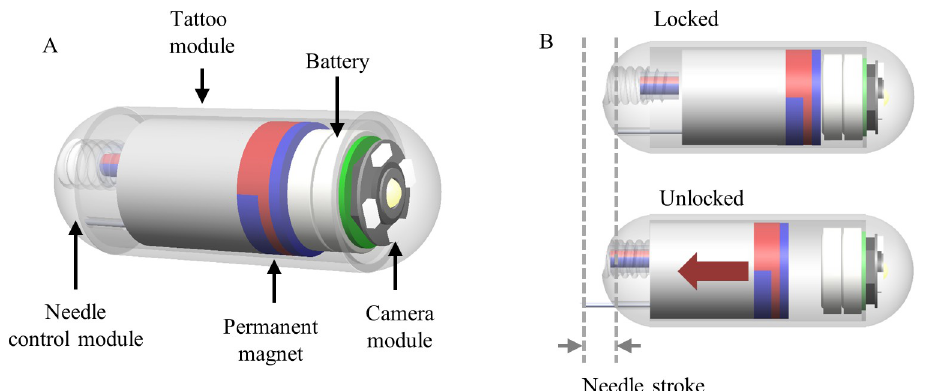
Fig 2. Schematics of the TCE. (A) Conceptual design of the WCE equipped with the tattoo module. (B) Two states of the NCM for needle extrusion.